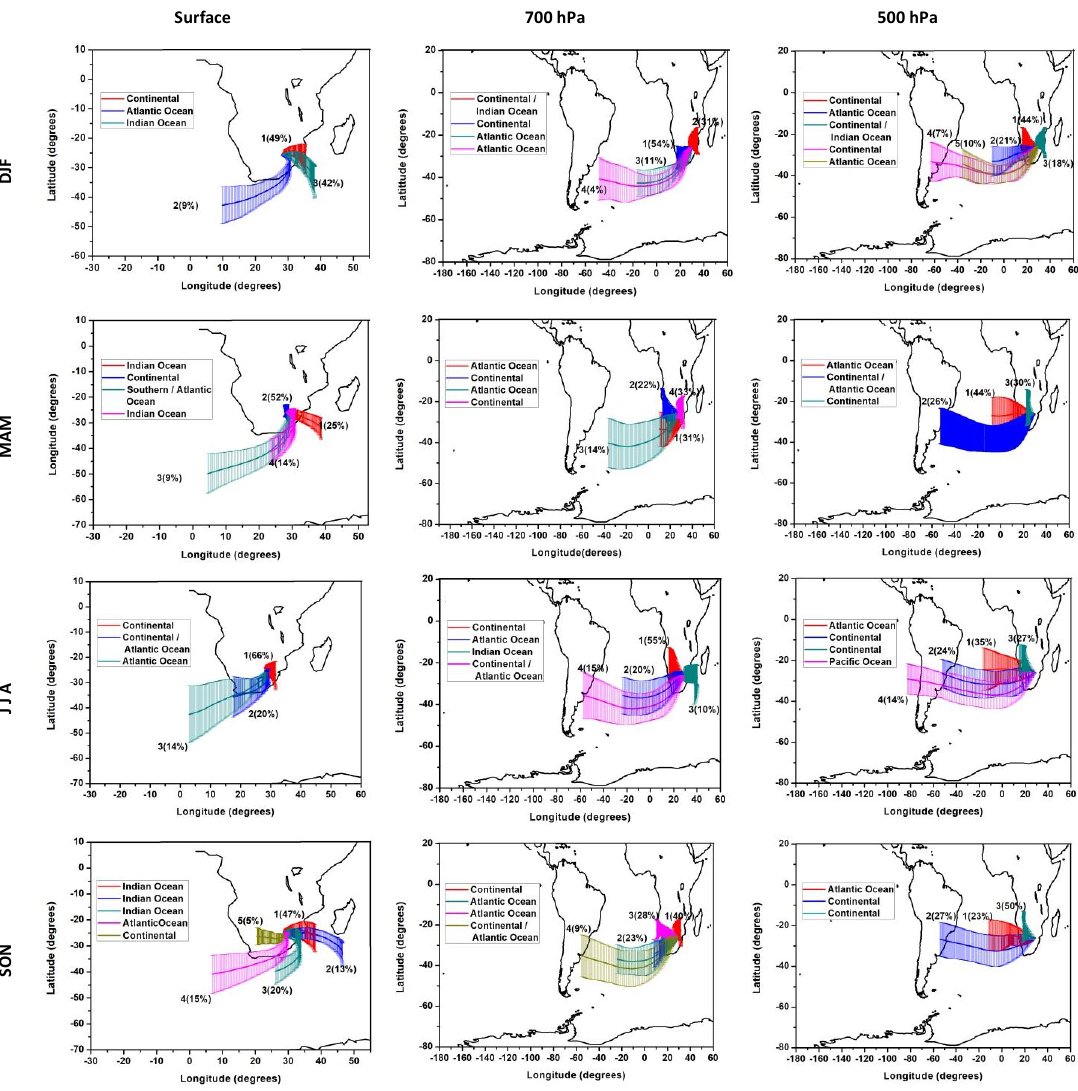
Figure 9. Seasonal 5-day backward trajectories illustrating air transport with its frequency impacting the CO 2 mixing ratios at the surface, above 3400, and 5500 m stable layers at the North East of South Africa area. From the ( top ) to the ( bottom ) row is the seasonal change from DJF to SON, while the ( left ), ( middle ), and ( right ) columns represent the atmospheric layers at the surface, above 3400 m, and 5500 m stable layers, respectively.